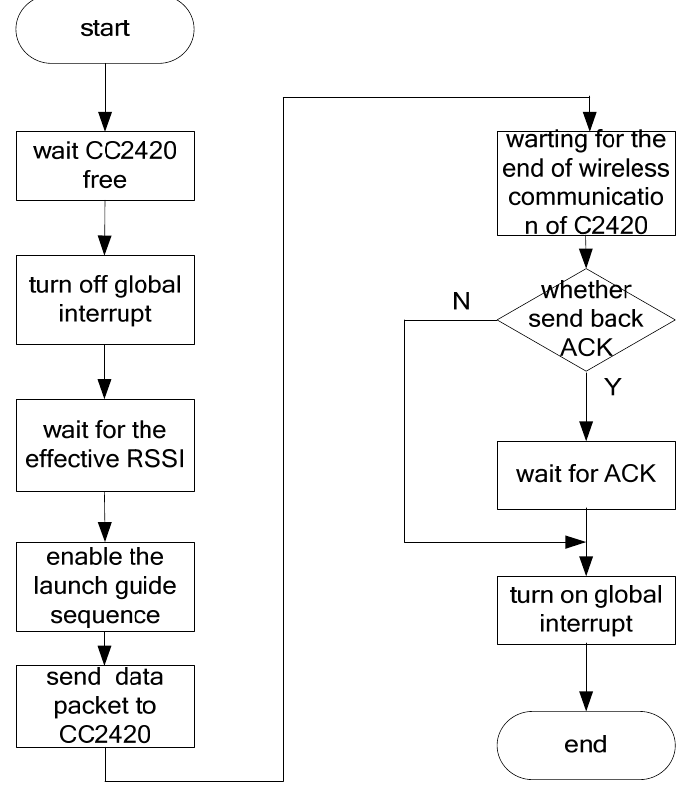
Figure 8. The flow diagram of the CC2420 send process.